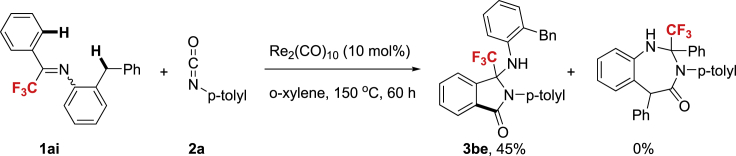
Intramolecular Competitive sp2 and sp3 C-H Bond Activation